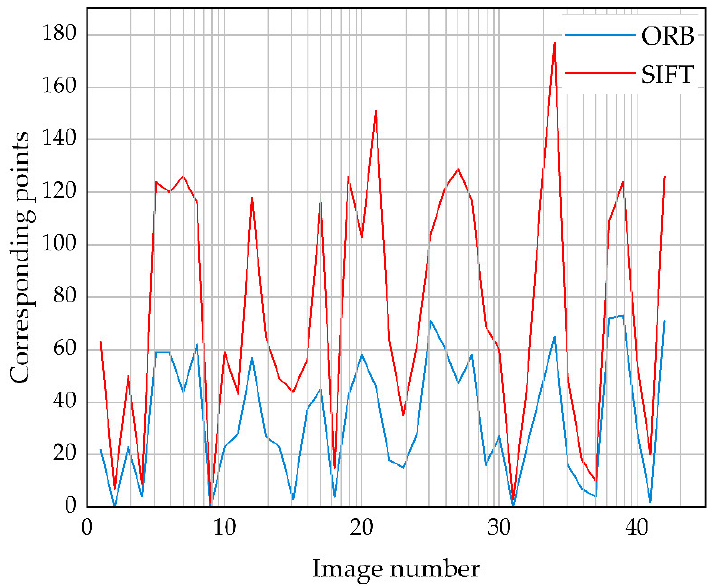
Figure 13. Comparison of the number of feature-corresponding points extracted by ORB [27] and SIFT [25] on 42 pairs of warped images and ground-truth images.